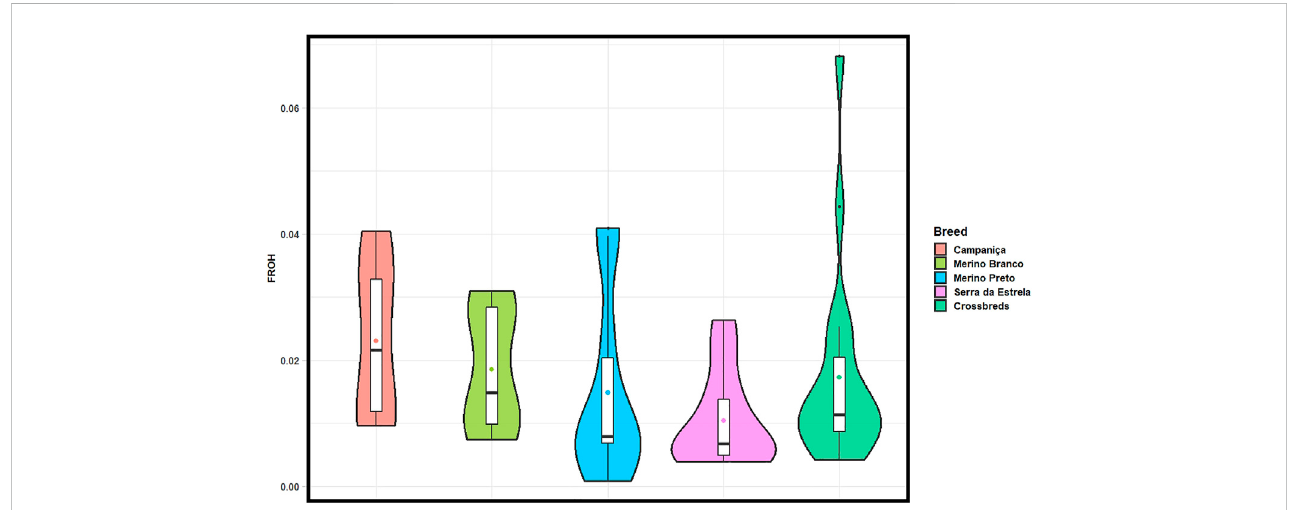
FIGURE 4 Violin plots showing ROH-based inbreeding coef fi cient (FROH) calculated in each population considering all ROH segments ( > 1 Mb). Mean values are represented by coloured circles.